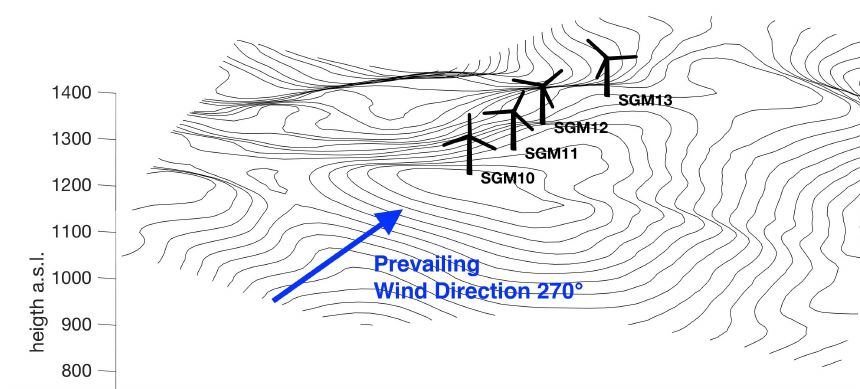
Figure 1. The layout and the inter-turbine distance of the subcluster under investigation. The four turbines are labelled with their names: SGM10, SGM11, SGM12 and SGM13. The terrain is represented with a contour line resolution of 20 m.